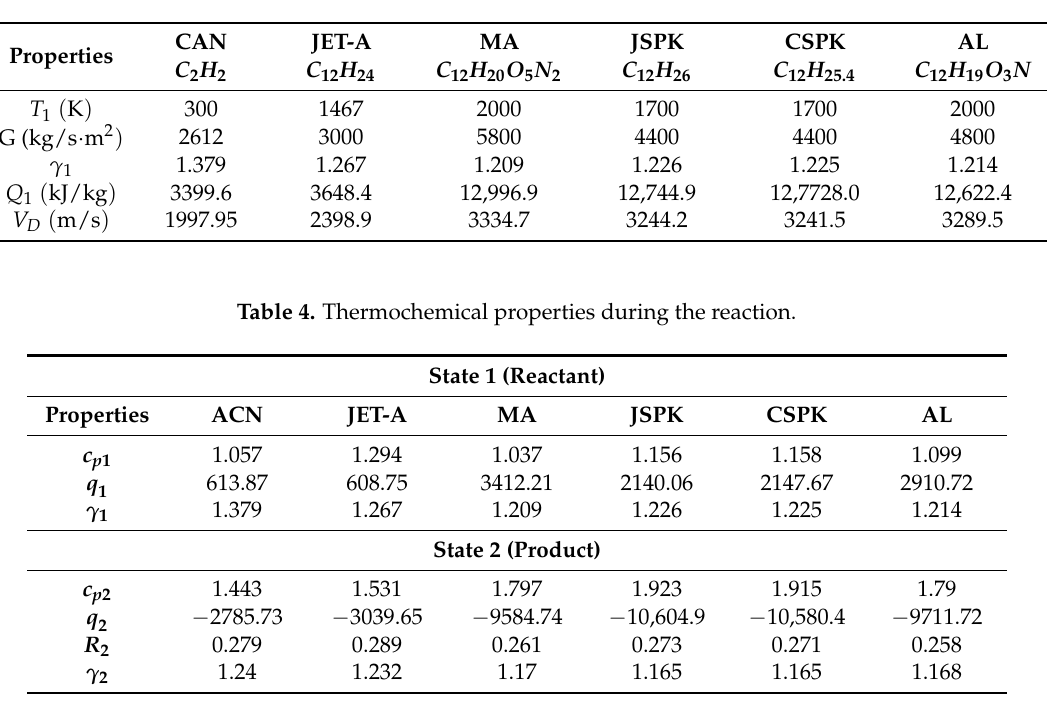
Table 3. Minimum initial temperature and mass flux for detonation.